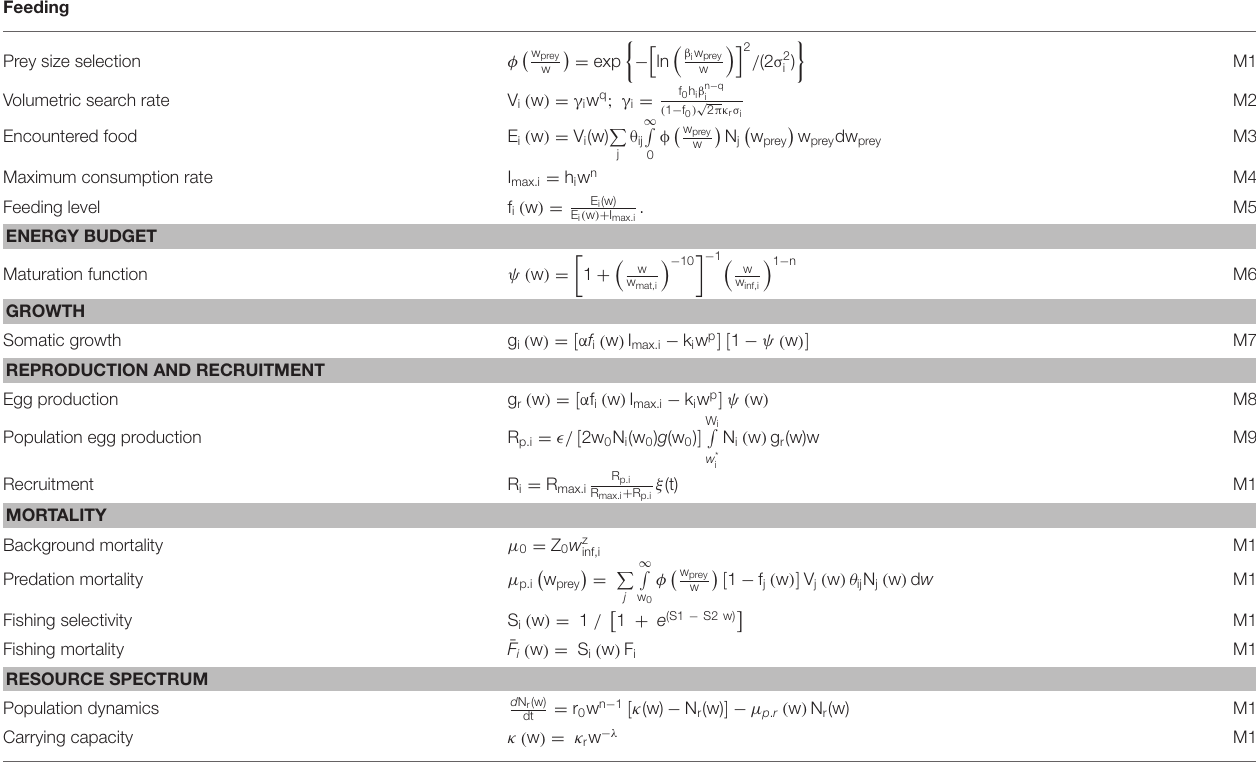
TABLE 1 | Multispecies size spectrum model (SSM) equations, modified from Blanchard et al. (2014) and Zhang et al. (2016).